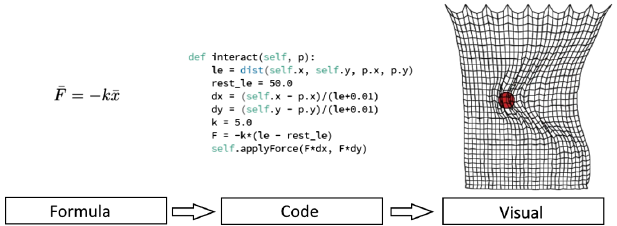
FIG. 4. Programming simulations requires transductions be- tween different types of semiotic systems that each provide different meaning potential. To move between different semiotic systems requires the student to define the transduction explicitly and highlights each aspect of the system to the